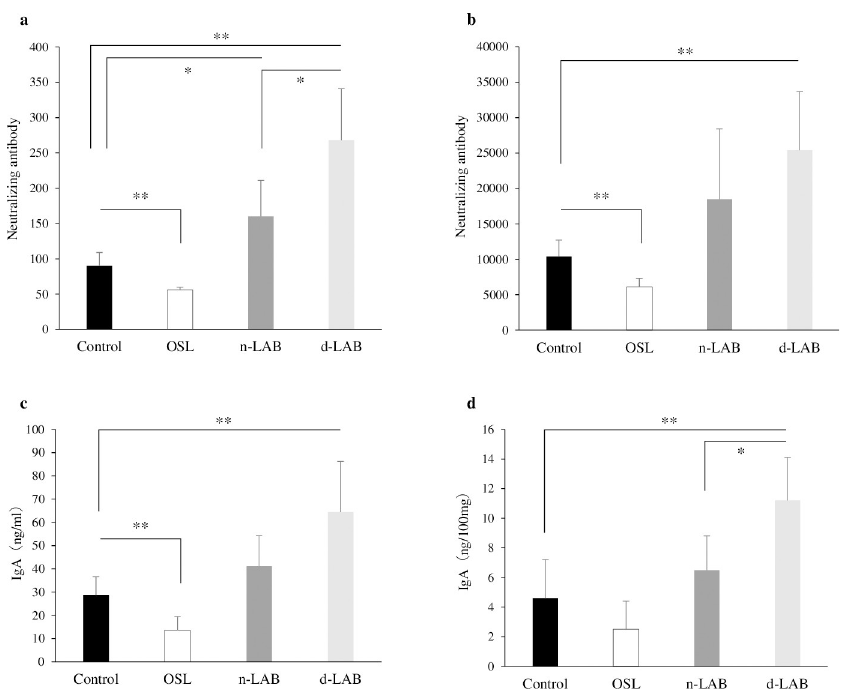
Fig 7. Effects of n-LAB or d-LAB administration on the neutralizing antibody titer and IFV-specific IgA production in mice. The titer of the virus-neutralizing antibody is presented as the reciprocal of the dilution of BALF samples ( a ) and sera ( b ) that reduced the plaque number to a level below 50% of that observed in the virus control. The IFV-specific IgA levels in BALF ( c ) and fecal samples ( d ) were determined using enzyme-linked immunosorbent assay. Each value is presented as the mean ± SD; n = 5; �� p < 0.01; � p < 0.05. BALF, bronchoalveolar lavage fluid; IFV, influenza A virus; d-LAB, dispersed lactic acid bacteria; n-LAB, non-treated lactic acid bacteria; OSL, oseltamivir.